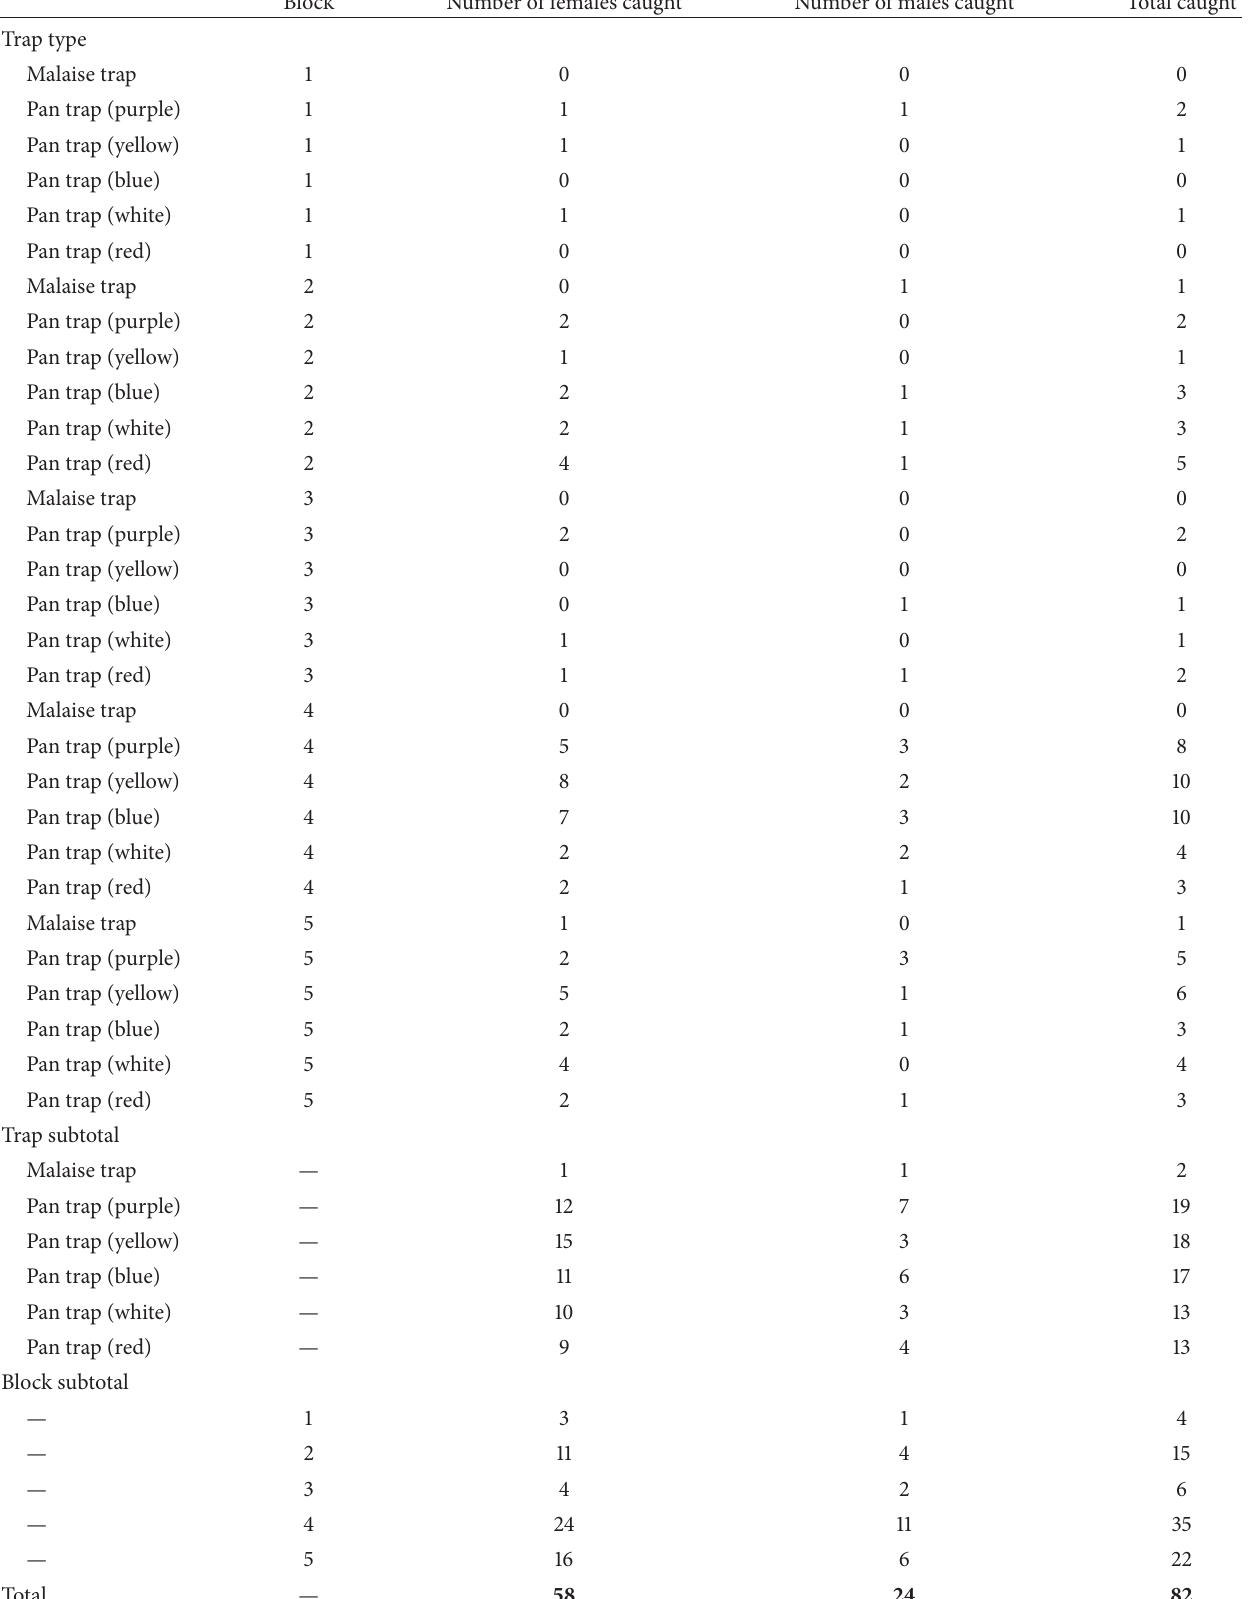
Table 1: Total number of Merope tuber collected per trap type per block, with subtotals of trap type and block. Block Number of females caught Number of males caught Total caught Trap